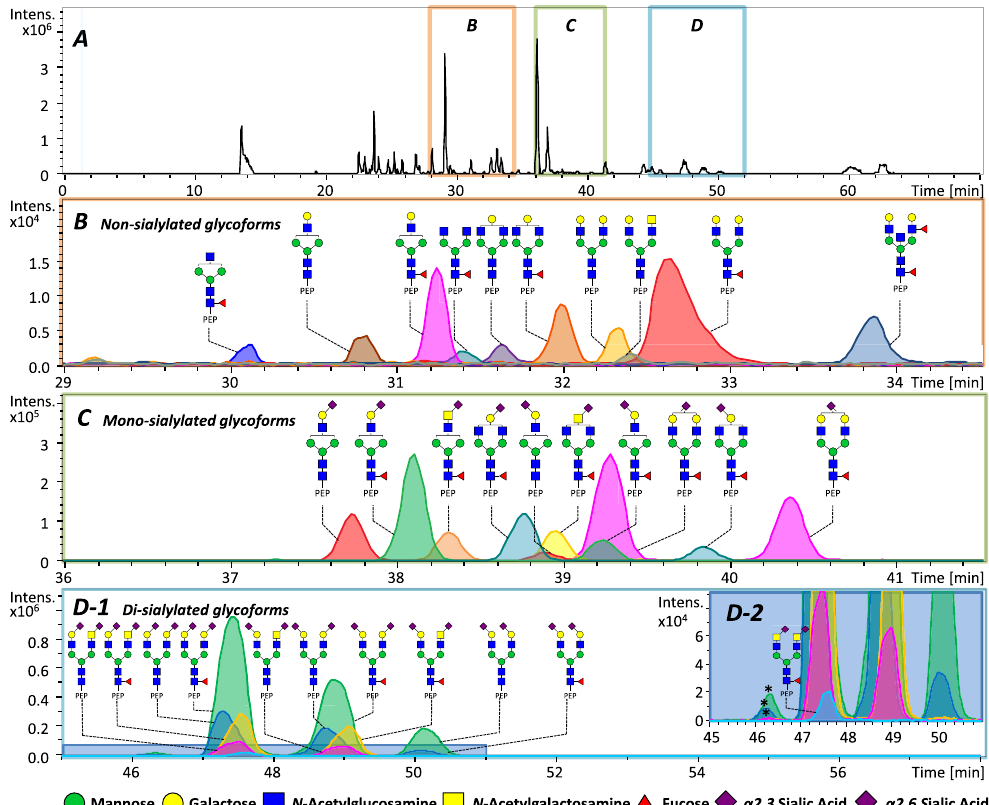
Figure 3. CE–ESI-MS analysis of PSA tryptic (glyco)peptides. ( A ) Representative base peak electropherogram observed for a tryptic digest of PSA. Based on the electrophoretic separation, three distinct clusters were defined. ( B ) Cluster with only non-sialylated glycopeptides of PSA. ( C ) Cluster containing mono-sialylated glycopeptides of PSA. ( D ) Cluster with di-sialylated glycopeptides of PSA. A total of 75 different glycopeptides were identified (not all data shown, a complete overview can be found in Table S-3, Supplementary Information). Peaks with a star ( * ) were not assigned. The “PEP” label illustrates the tryptic peptide sequence N 69 K to which the glycan is